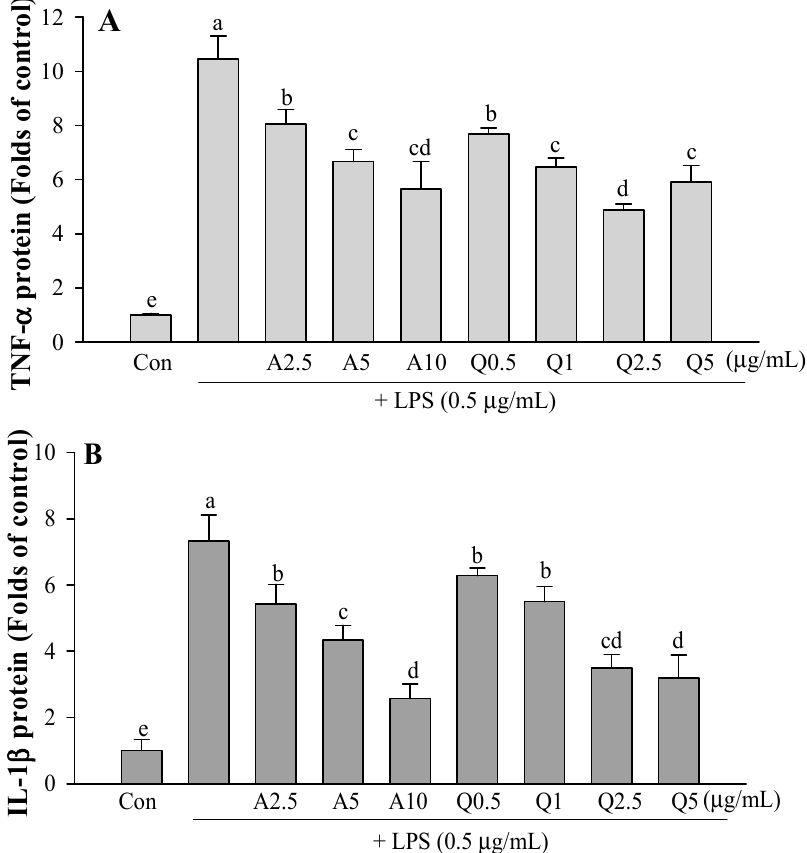
Figure 5. Effect of Ast and Que on TNF- α ( A ) and IL-1 β production ( B ) in LPS-activated microglia. Con, control: LPS- and sample-untreated cells; Group LPS: cell treated with LPS only. The values shown are the mean ± SD ( n = 3) and means labelled with different letters (a–e) differ significantly as shown by Duncan’s multiple range test ( p < 0.05).